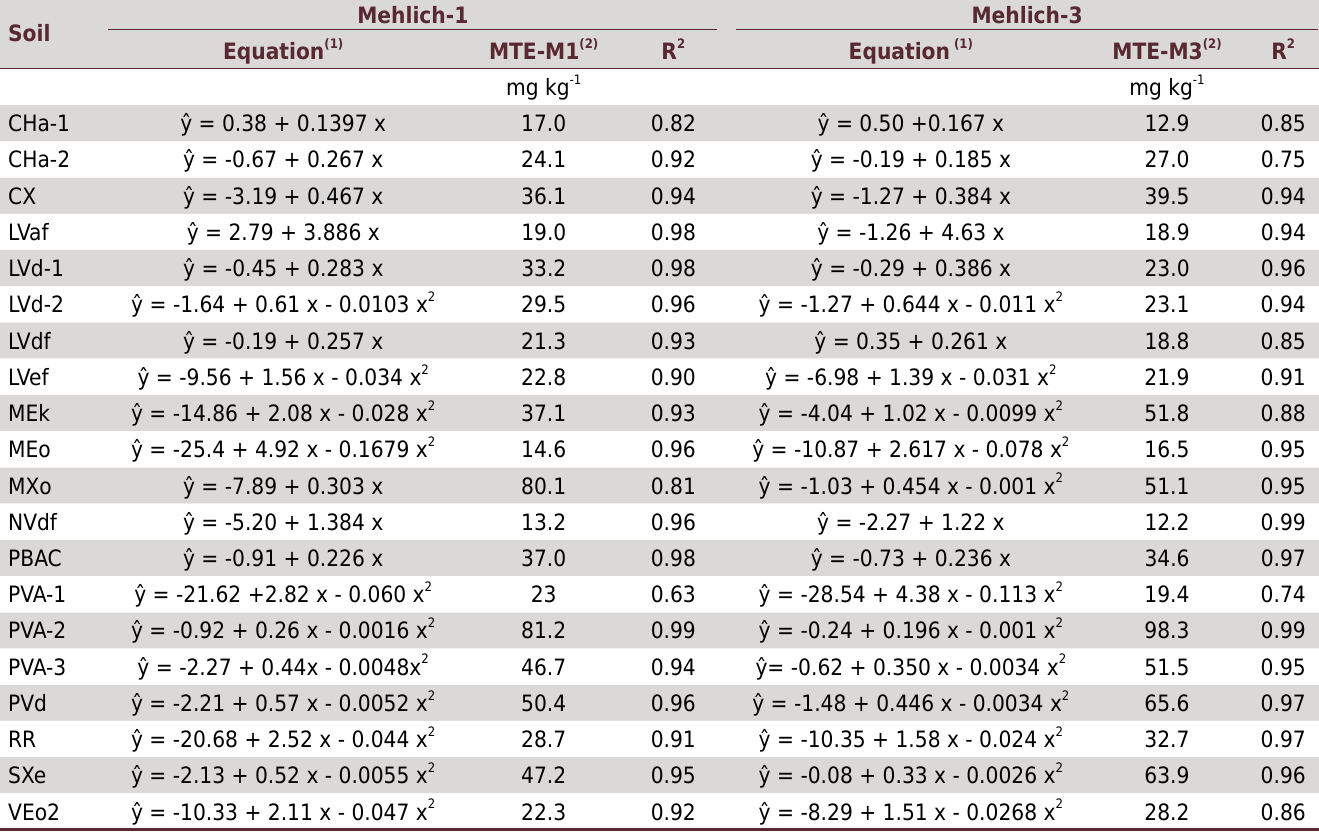
Table 4. Polynomial regression equation, coefficient of determination (R 2 ) and phosphorus content for maximum technical